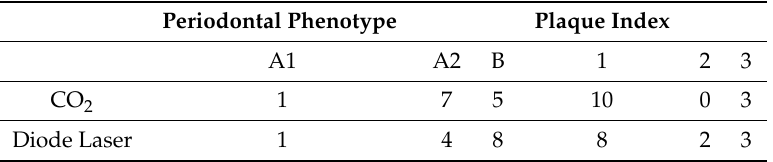
Table 1. Incidence of plaque and features of periodontal